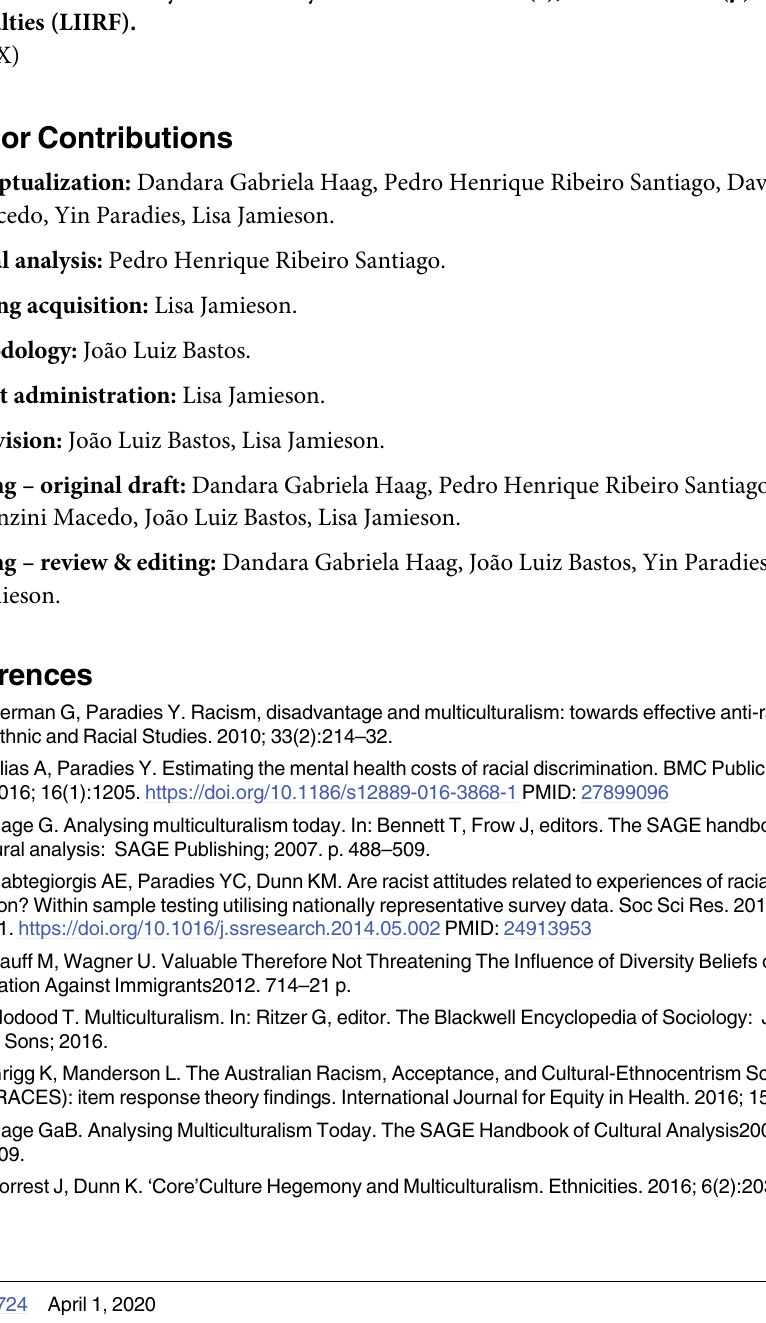
S1 Table. Exploratory Factor Analysis: Factor loadings ( λ s) and bootstrapped 95% CI. S2 Table. Matrix of residual correlations. S3 Table. Matrix of inter-item correlations. S4 Table. Confirmatory Factor Analysis: Item thresholds ( τ ), item locations ( β ) and item difficulties